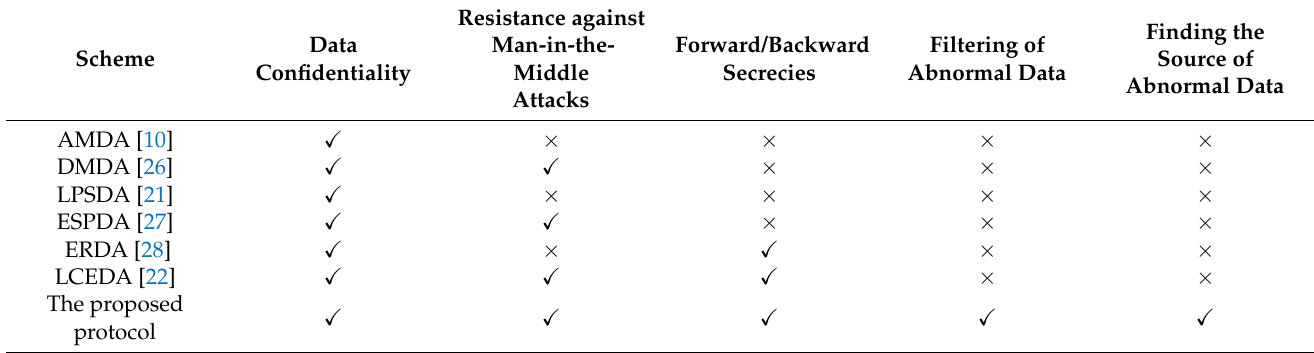
Table 2. Security feature comparisons.